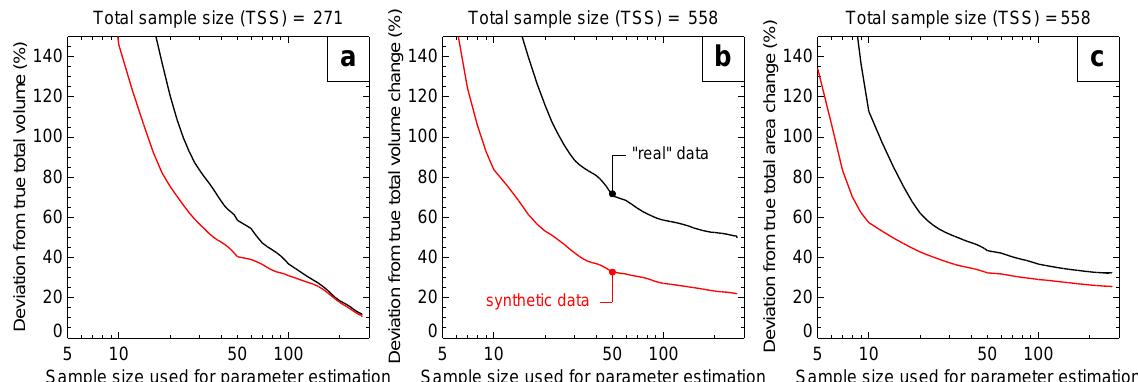
Fig. 5. Accuracy (95% of confidence) with which the true total (a) volume, (b) volume change, and (c) area change can be recovered for a given glacier population by using volume–area scaling if the parameters of the scaling relation are estimated from a subsample of (A,V)-data of a given size. The two lines depict the cases in which the accuracy is estimated from synthetic (black) and real (red)